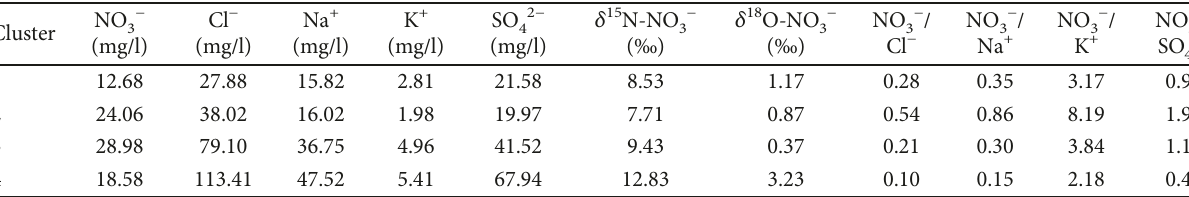
Table 4: Average values of parameters in de fi ned clusters.